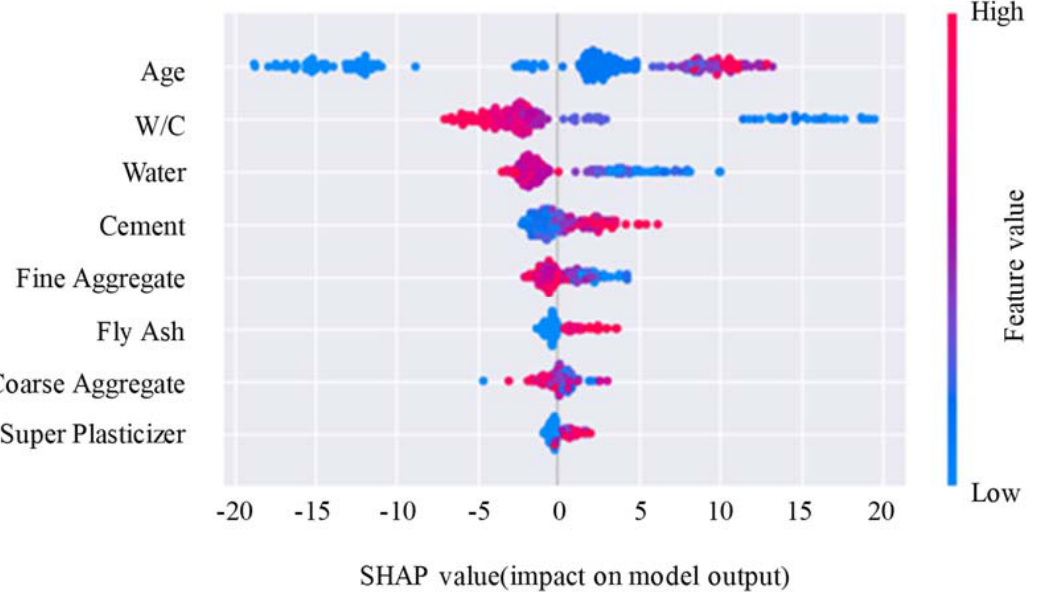
Figure 11. The SHAP summary plot of the compressive strength.